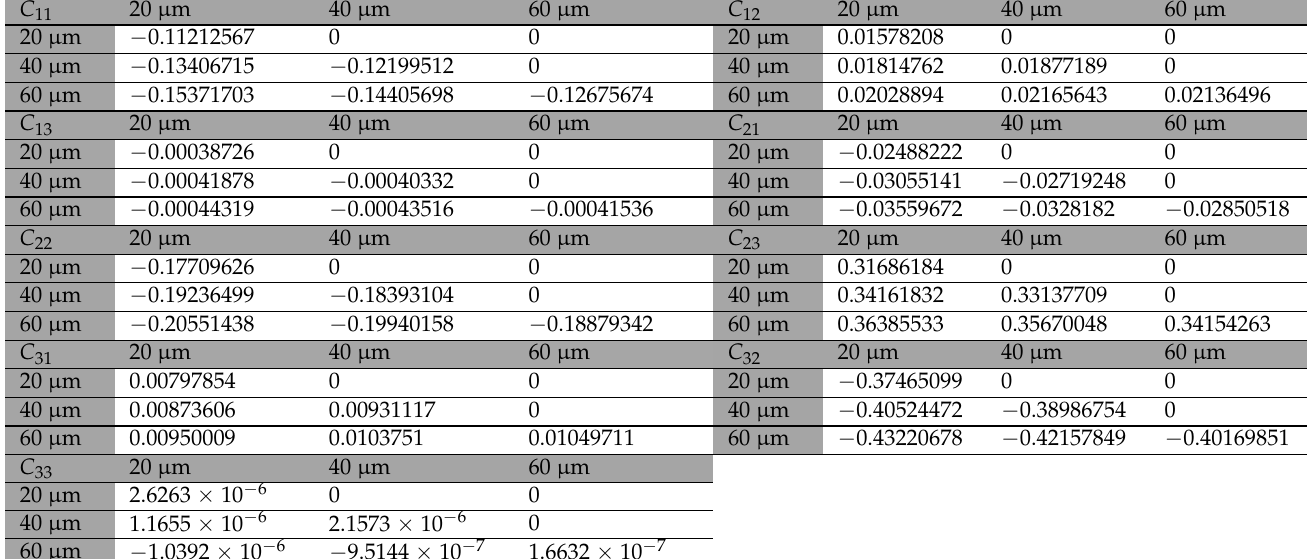
Table 2. Calibration coefficients C kl 11 *10 − 6 for the GFRP sample. Values are related to the first three increments in the framework of the integral method. See text for